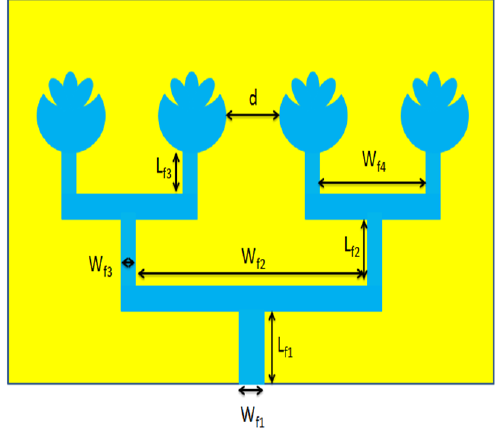
Figure 3. Type C dual-band THz antenna